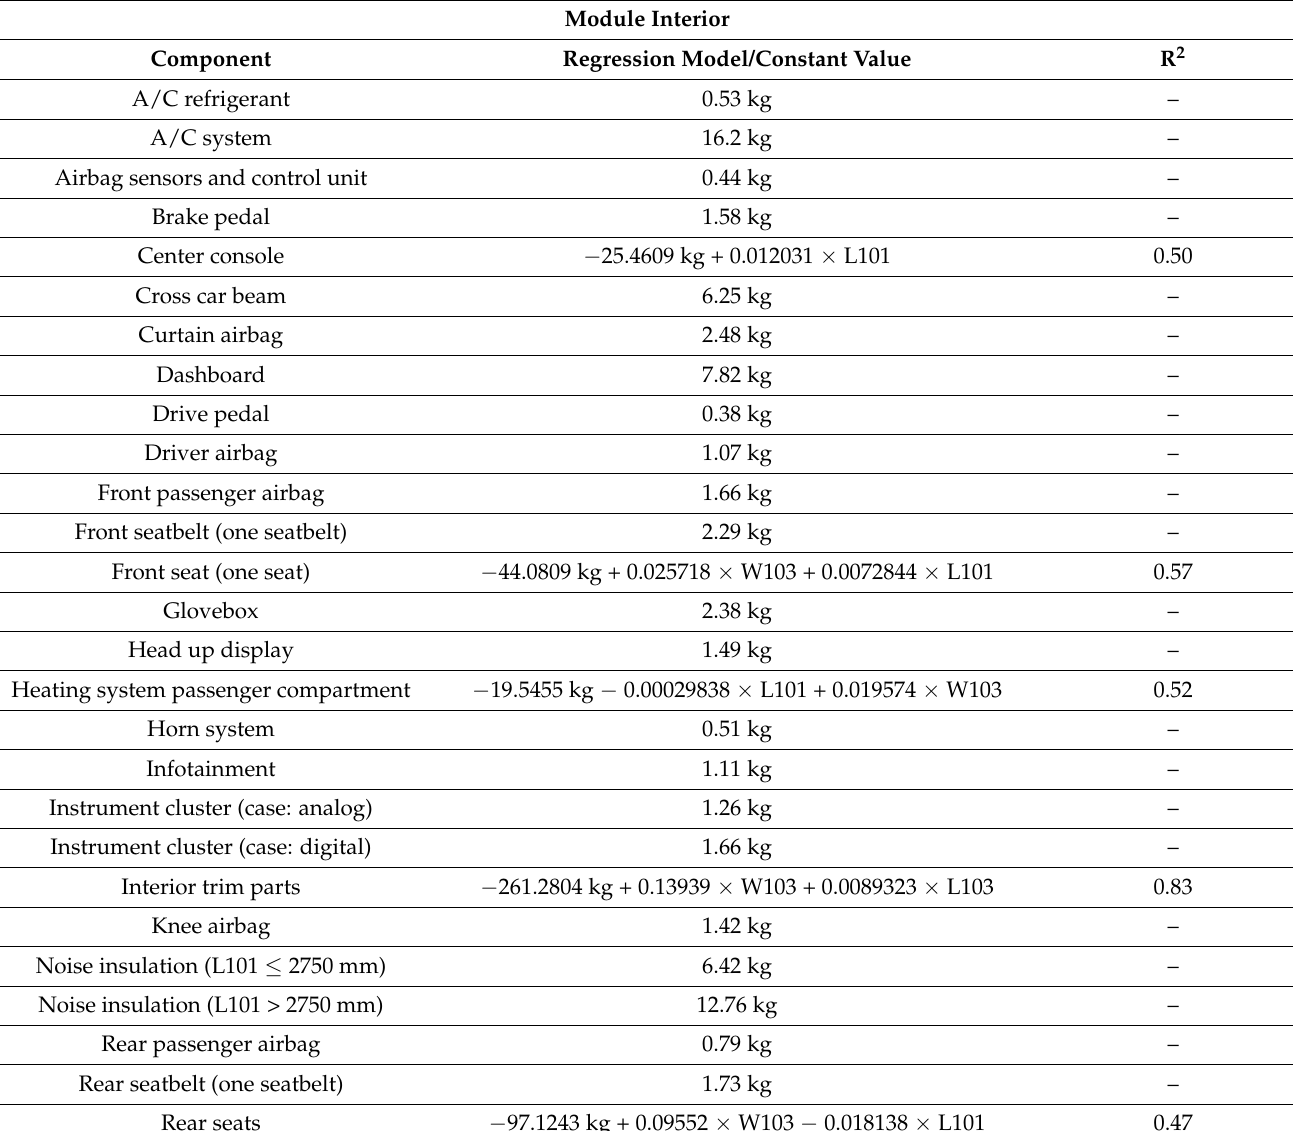
Table A7. Empirical models for the Interior